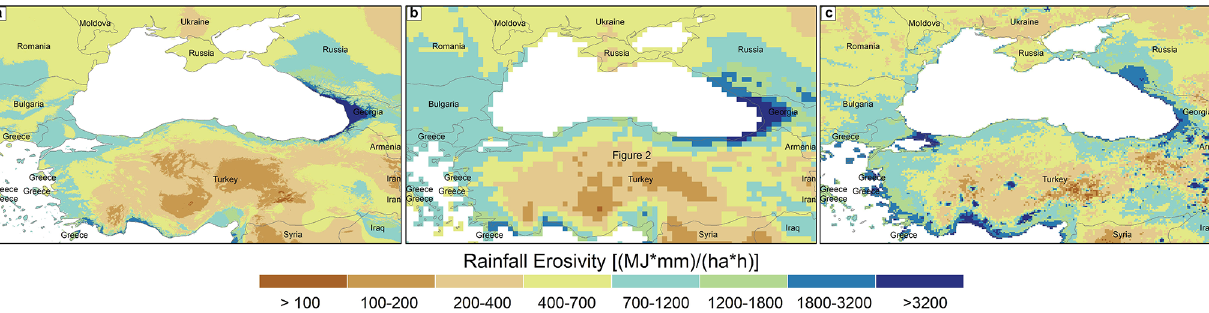
Figure 4. An example of relatively good agreement between the GloREDa (a) , ED (b) , and CMORPH (c) maps for parts of eastern Europe and Turkey. Table 4. Comparison between monthly rainfall erosivity characteristics for Europe using Ballabio et al. (2017), the ED concept, and the CMOPRH